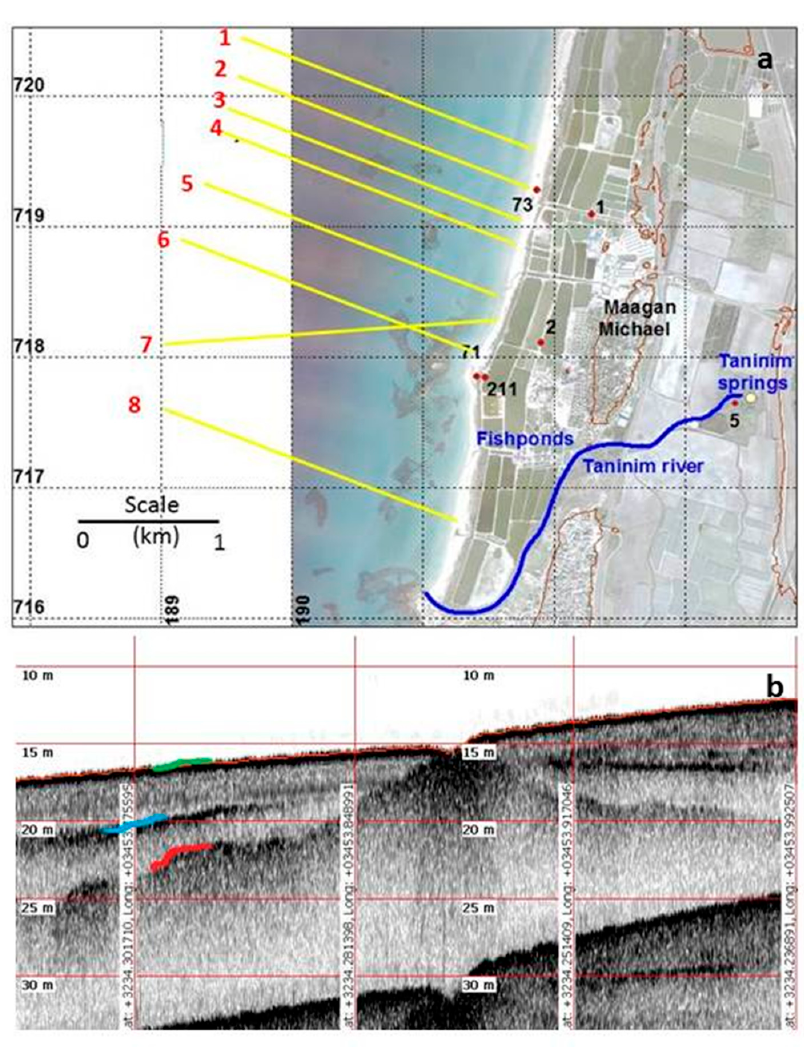
Figure 7. Location map of the CHIRP survey lines ( a ) and CHIRP seismic interpretation along part of Section 2 ( b ). The top calcareous sandstone (‘Kurkar’) layer is shown by red line, the top clay layer by blue line and the seabed by green line.